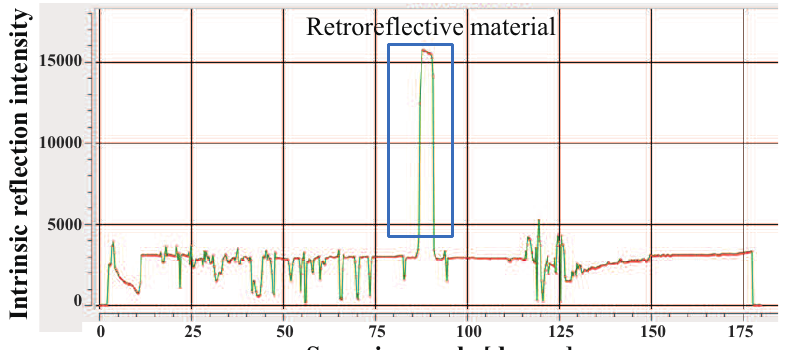
Figure 8. Reflection intensity value of retroreflective